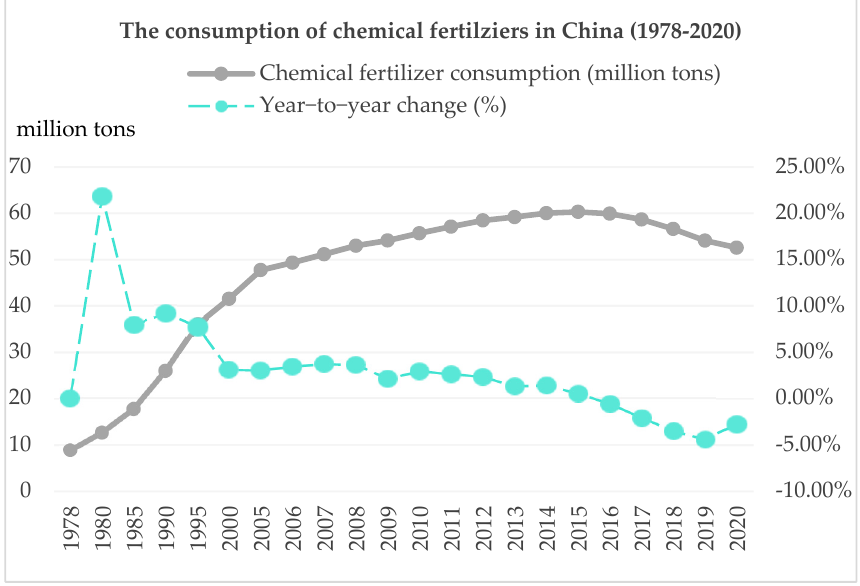
Figure 1. The consumption of chemical fertilizers in China from 1978 to 2020. Source of data: National Bureau of Statistics of China, 2021.